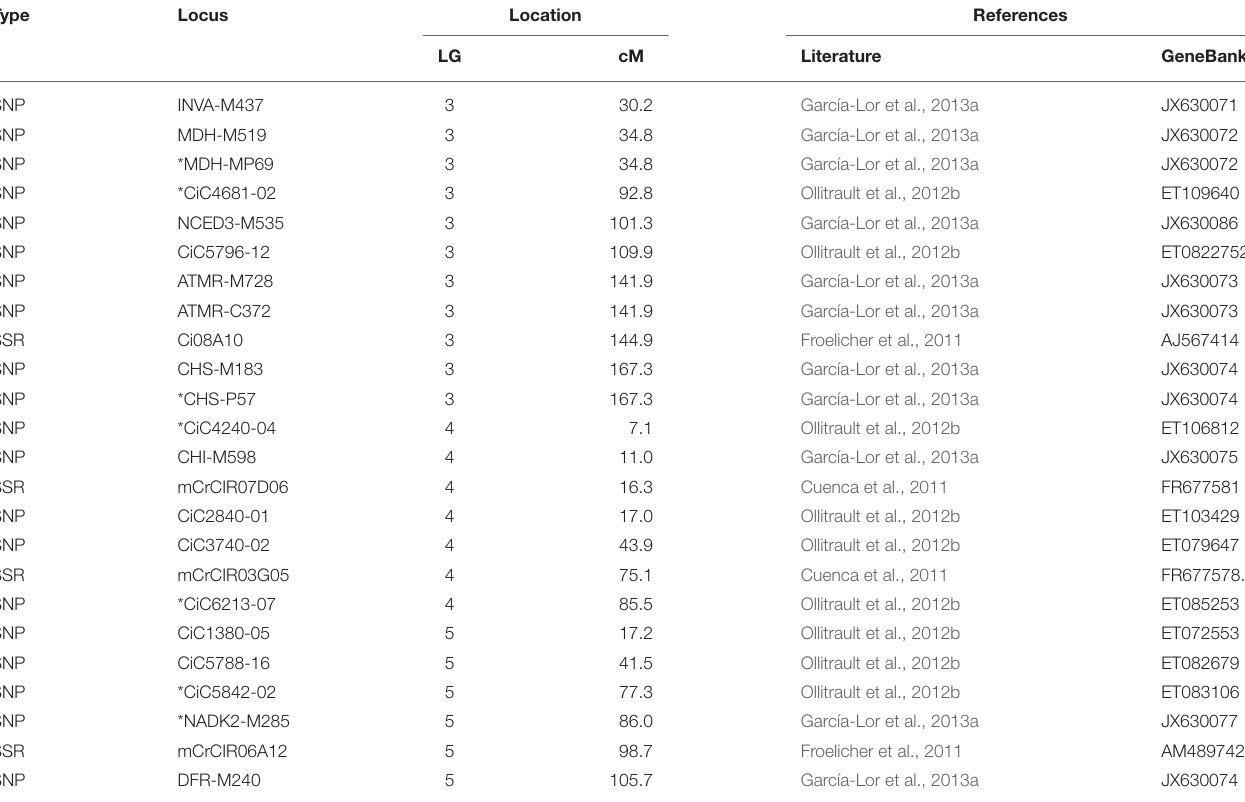
TABLE 2 | Molecular markers analyzed indicating the type of marker, locus name, linkage groups (LGs) 3, 4, and 5 and location within LG in centimorgans (cM), bibliographic reference in the literature, and GeneBank accession.